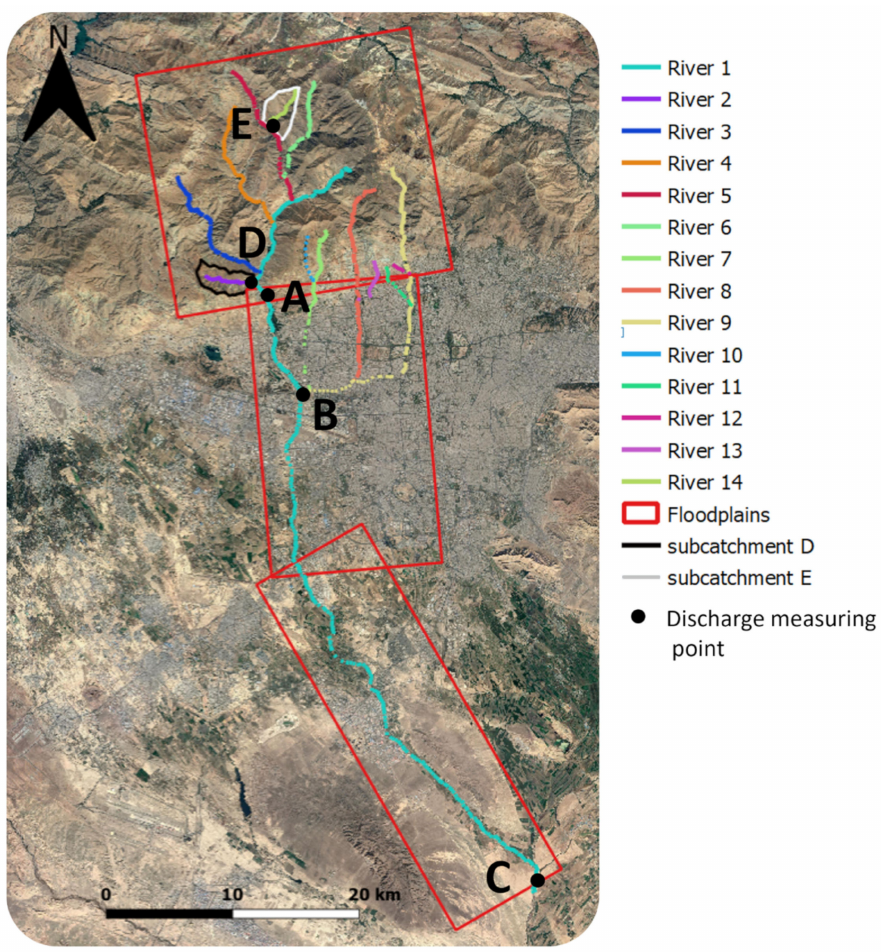
Figure 2. The 1D–2D hydrodynamic model for the Kan catchment. Discharge is measured at 5 locations during the simulations. Point A (end of the upper subdomain) and C (end of the lower subdomain) are located on the Kan River itself, whereas point B is just upstream of the confluence of a tributary of the Kan River (i.e., does not gauge the discharge of the Kan River itself). Points D and E are located at the end of two sub-catchments in the upper